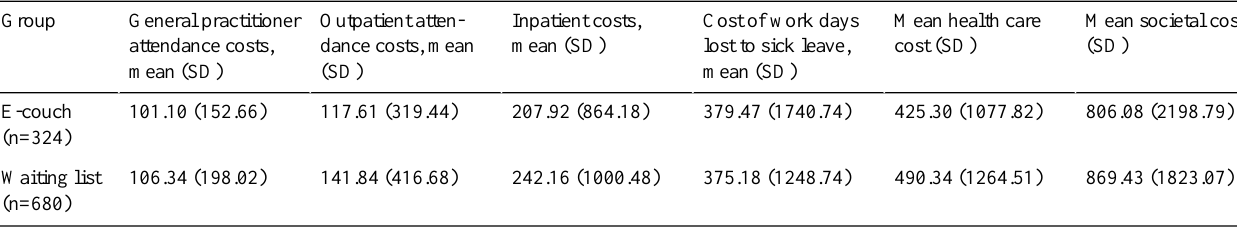
Table 4. Health care utilization and other costs at 12 months (£).